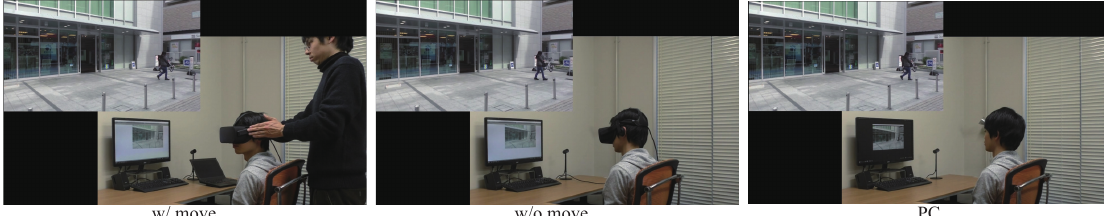
Figure 2. Appearance of participant watching video taken in the shopping